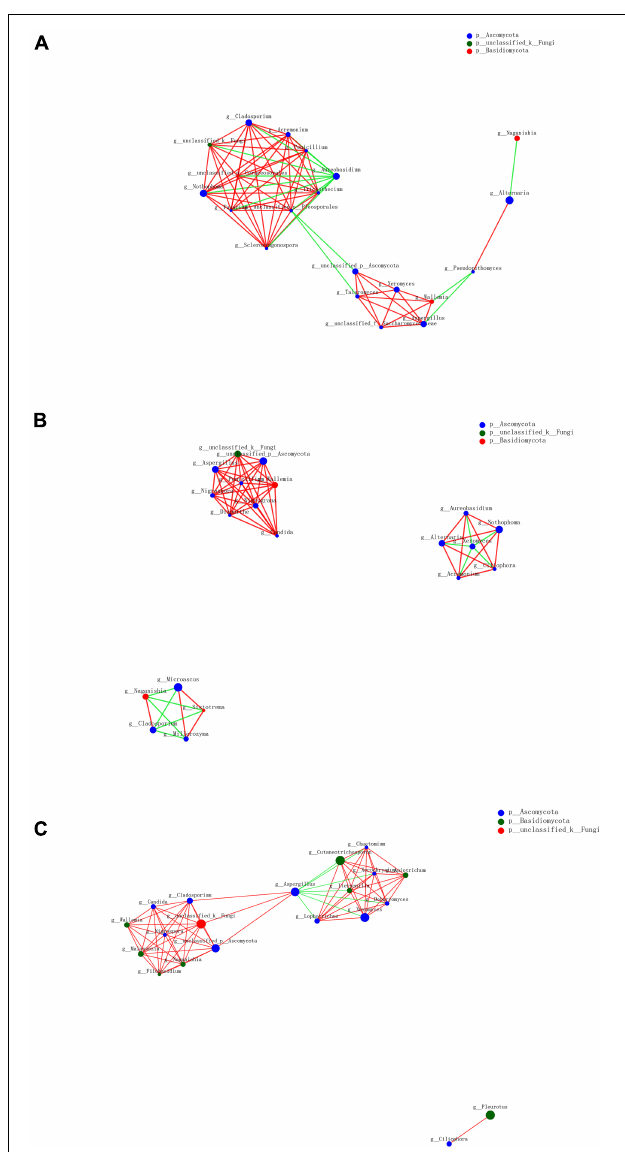
FIGURE 9 | Network analysis of fungal taxa in (A) SDD group, (B) SDR group, and (C) SDC group.